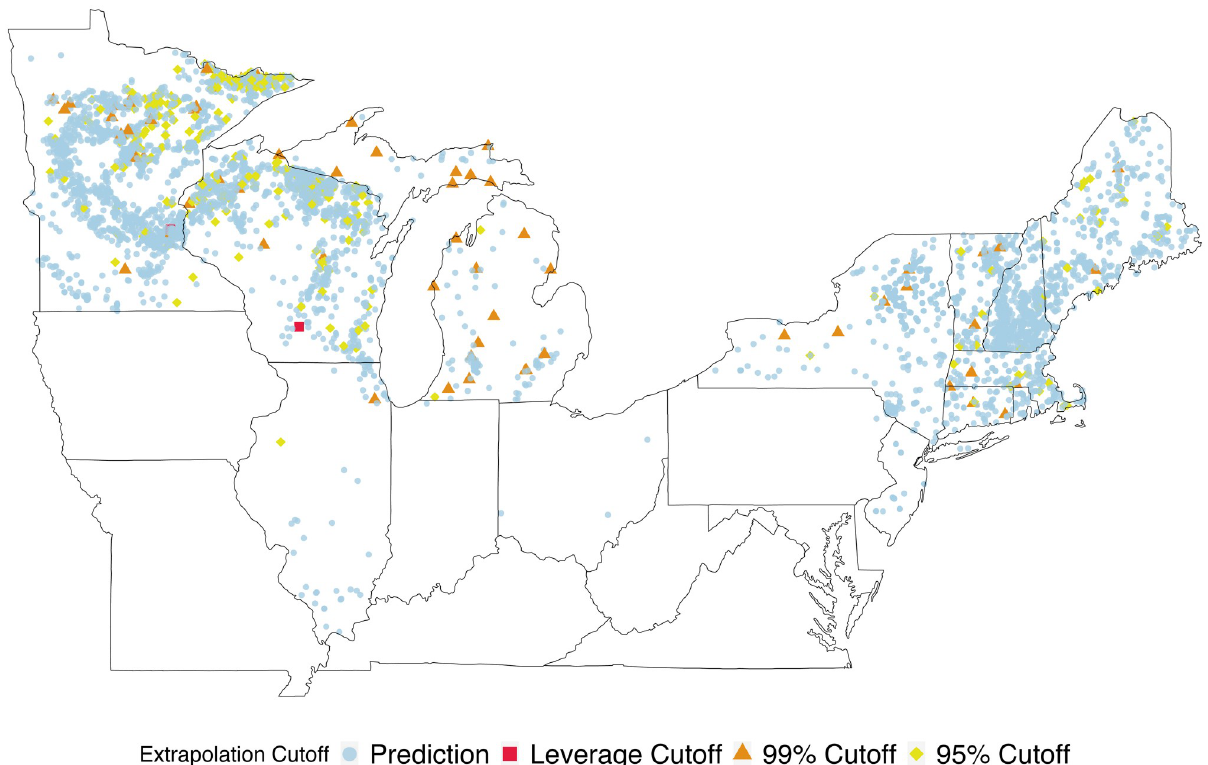
Fig 5. Identification and locations of prediction vs extrapolation of the single response variable, TN. Four cutoff approaches are compared and presented. Lakes in blue circles represent locations where TN predictions have been not been identified as extrapolations for any cutoff choice. Lakes in red squares, orange triangles, and yellow diamonds indicate those where predictions were beyond the cutoff values and thus considered extrapolations. The color and shape of extrapolated lake locations are determined by which cutoff value first identifies the prediction at that location as an